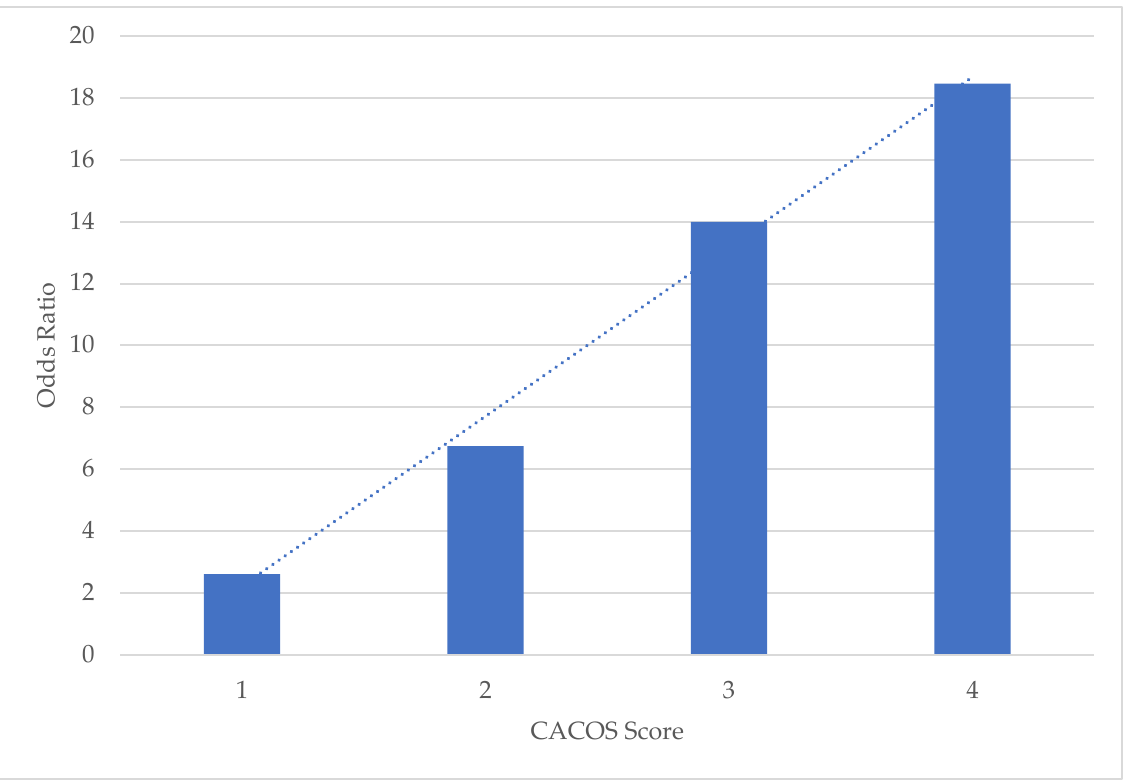
Figure 2. Inpatient mortality post-cardiac arrest in active cancer by Cardiac Arrest Cardio-Oncology Score (CACOS) according to univariable regression ( N = 19,280).